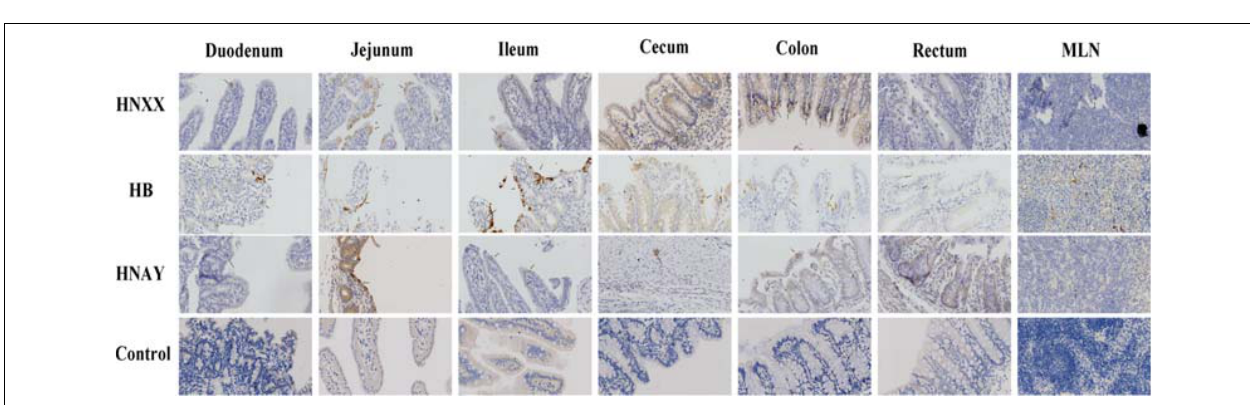
FIGURE 8 | PEDV antigens detection in different intestinal tissues of piglets infected with PEDV isolates by immunohistochemistry. The representative pictures of viral antigens in duodenum, jejunum, ileum, caecum, colon, rectum, mesenteric lymph nodes of intestines from piglets of each group are shown, and antigens are depicted as arrows. Original magnifications: ×